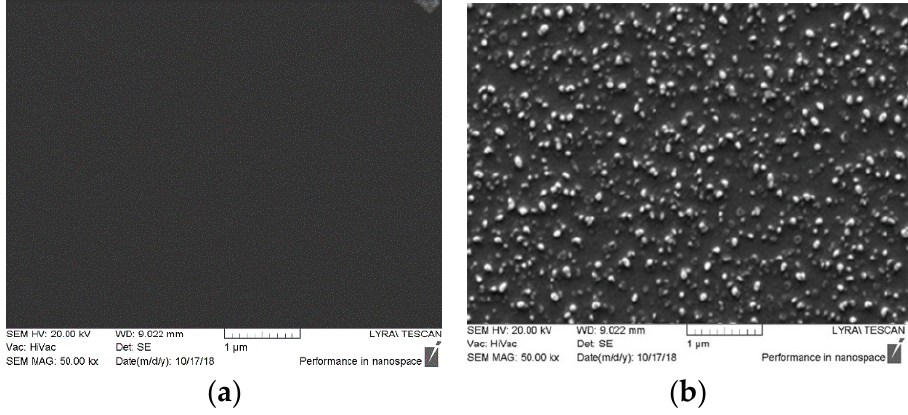
Figure 2. Morphology of: ( a ) TiO 2 magnetron sputtered coating on glass substrate (×5000); ( b ) TiO 2 /Ag 23.1 at.%/ Cu 21.6 at.% magnetron cosputtered coating on glass substrate, Sample 5.